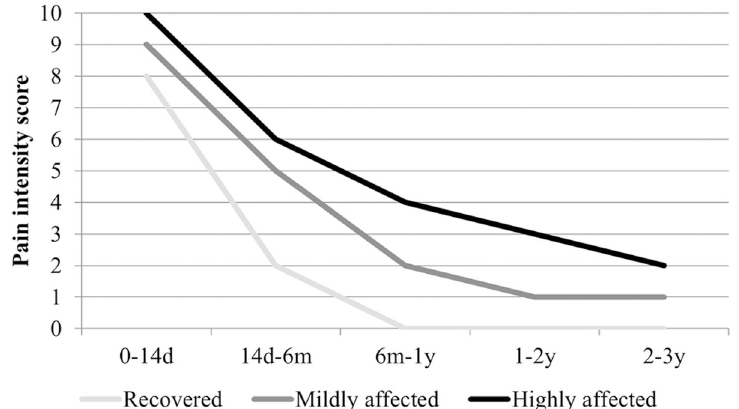
Fig 4. Chikungunya disease pain intensity scores. The horizontal axis shows the different time intervals, between disease onset in 2014–2015 (0d) and 2–3 years after disease onset in 2017. The vertical axis shows the median pain intensity visual analogue scale score (0 = no complaints at all; 10 = worst possible complaints I can imagine) of the recovered n = 107, mildly affected n = 87, and highly affected n = 54 groups, classified in 2017. Groups were compared using the chi-square test, two-sided P-value < .001. Abbreviations: d, day; m, months; y, years.